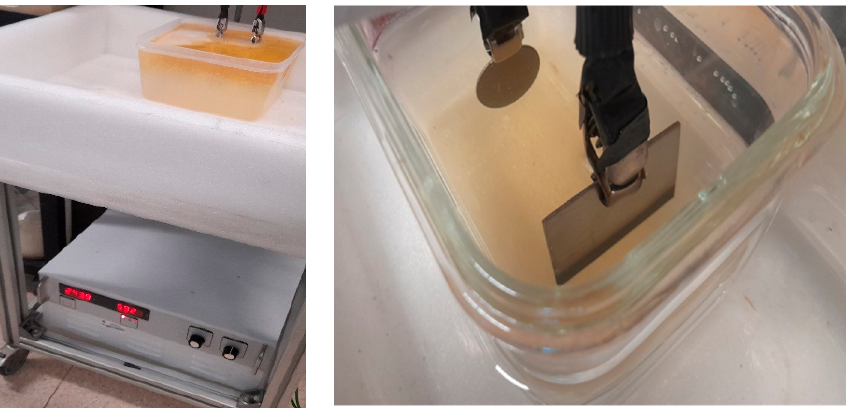
Figure 1. System used to achieve oxy-nitriding by the SSONPE process. The treated surfaces were characterized by XPS, using a Thermo Scientific k-Alpha TM spectrophotometer with an internal pressure chamber of 6.5 × 10 − 8 mbar, a monochromatic Al-k α X-ray source (hv = 1486.68 eV) and a 400 µ m analysis radius. The crystalline phases on the treated steel surfaces were determined by DRX, using a Bruker AXS D8 Advance TM diffractometer. The operation conditions were a CuK alpha wavelength of 1.5418 A, a voltage of 40 kV, a current density of 30 mA, and an aperture of 0.02 ◦ (2 θ ) per